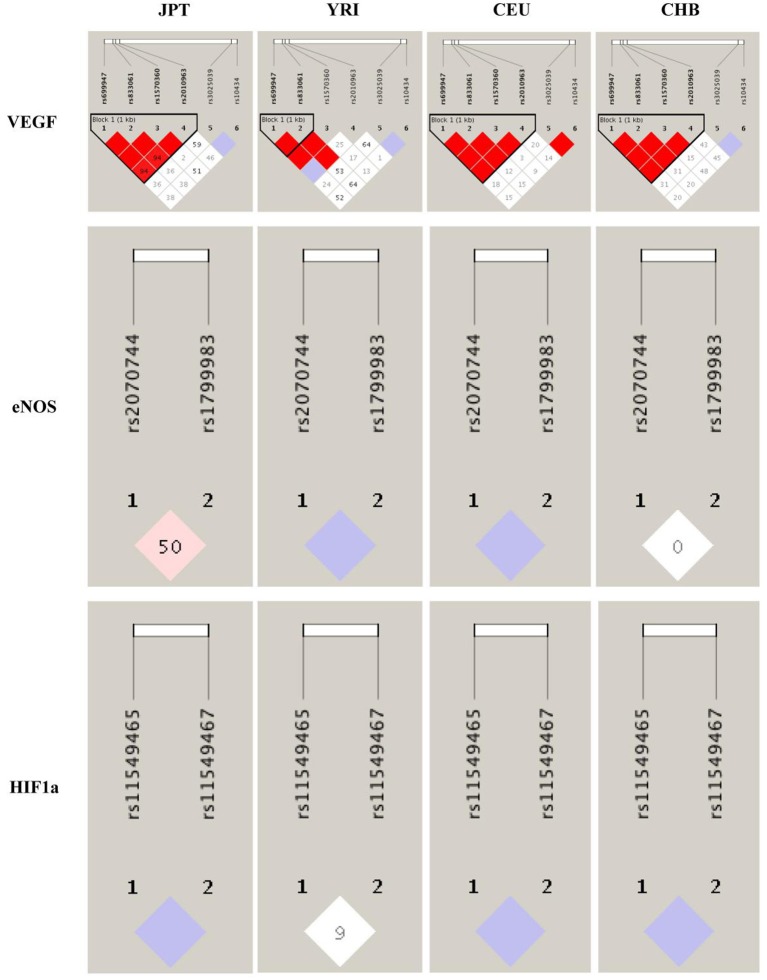
Linkage disequilibrium analyses for VEGF, eNOS, and HIF1α polymorphisms in populations from 1,000 genomes. The number of each cell represents r2 and white color cells shows no LD between polymorphisms. Population descriptors: JPT, Japanese in Tokyo, Japan; YRI, Yoruba in Ibadan, Nigeria; CEU, Utah residents with Northern and Western European ancestry from the CEPH collection; CHB, Han Chinese in Beijing, China.